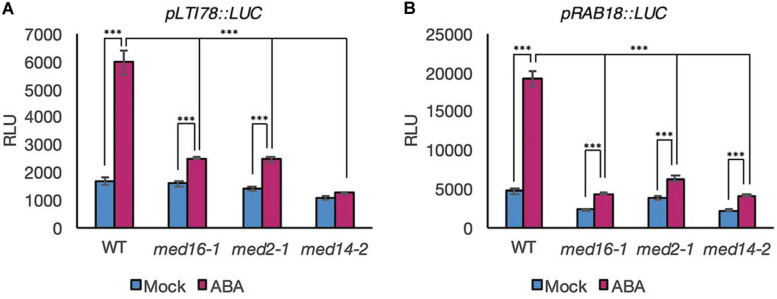
Luciferase activity driven by the promoter of specific ABRE- and DRE-containing genes in response to ABA is lower in mutants of the Mediator subunits MED2, MED14, and MED16 compared to the WT. Luciferase activity measured in protoplasts transformed with a pLTI78:LUC
(A), or pRAB18:LUC
(B) construct and exposed to 30 μM ABA (pink bars) or mock treatment (blue bars) for 3 h. Data shown are mean values of four repeats. Error bars represent ± one SE. Asterisks denote significant difference between the indicated treatments or genotypes: ***P < 0.001. One representative experiment out of three is presented.